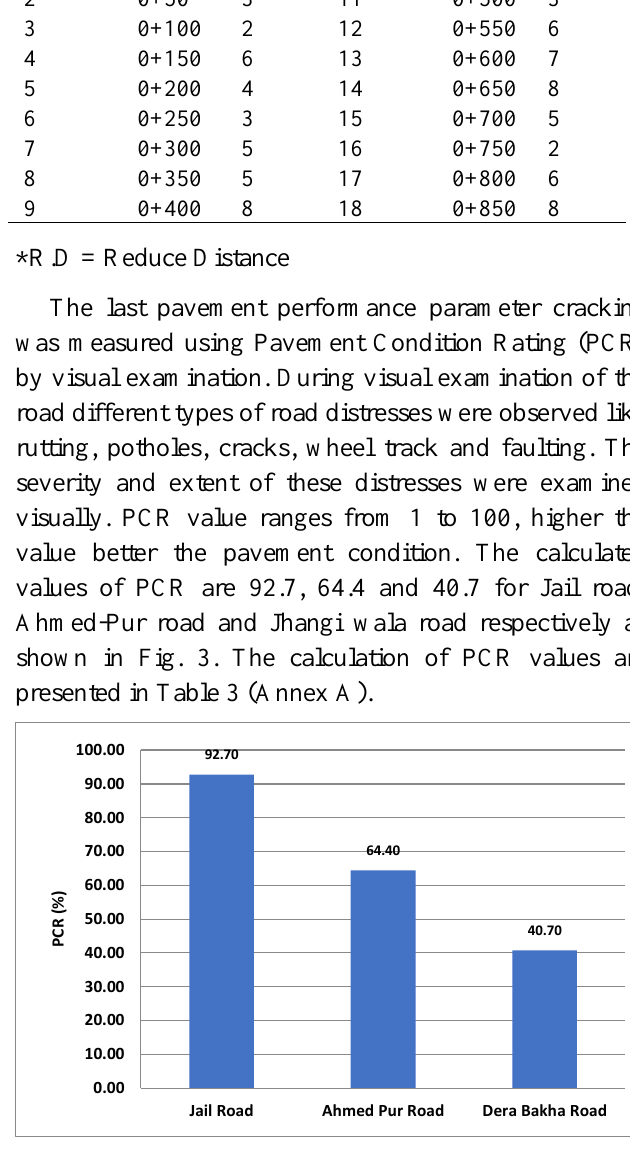
Fig. 3. Pavement condition rating